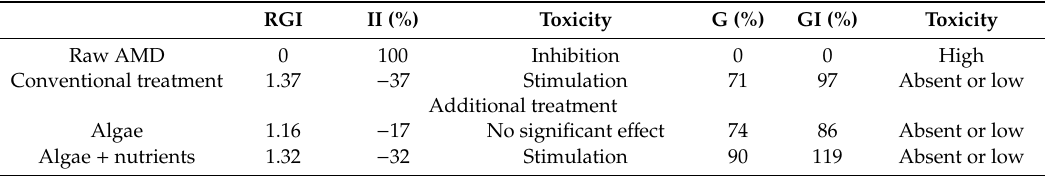
Table 2. Relative growth index (RGI), inhibition index (II), germination (G) and germination indices (GI) of Allium cepa roots for control (H 2 O); raw AMD; AMD after conventional treatment; and AMD after additional treatment with algae without and with nutrients addition. RGI II (%) Toxicity G (%) GI (%) Toxicity Raw